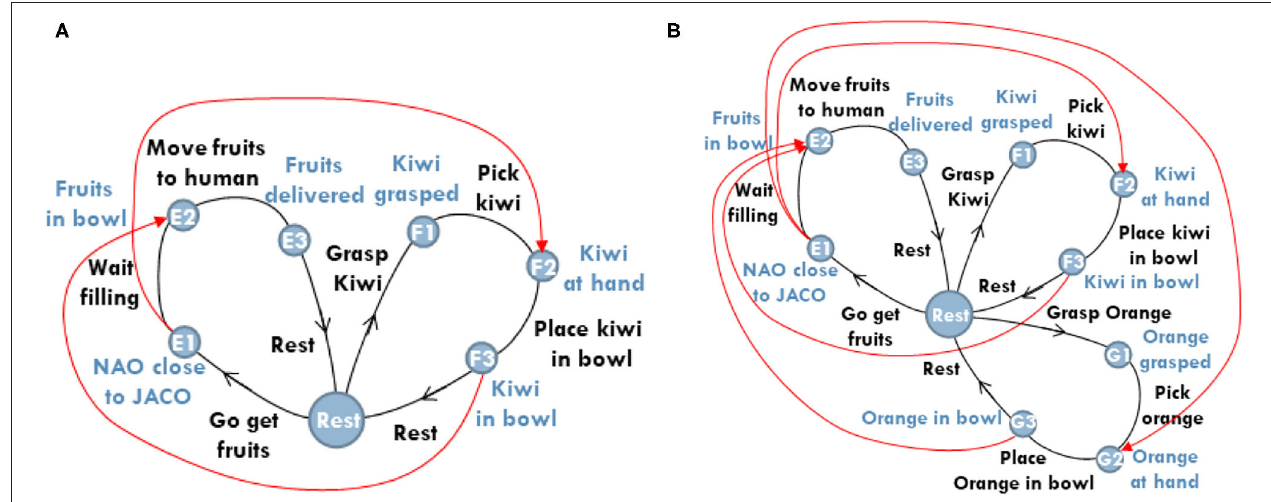
FIGURE 5 | Exemplar cases of plan constraints, depicted in red. (A) Illustrates the case of two constraints used to prioritize the actions of petals implemented in parallel. (B) Illustrates the case of two constraints on E 2. As soon as F 3 is reached, the planner releases the constraint G 3 → E 2, to comply with temporal constraints (i.e., avoid the delay of breakfast